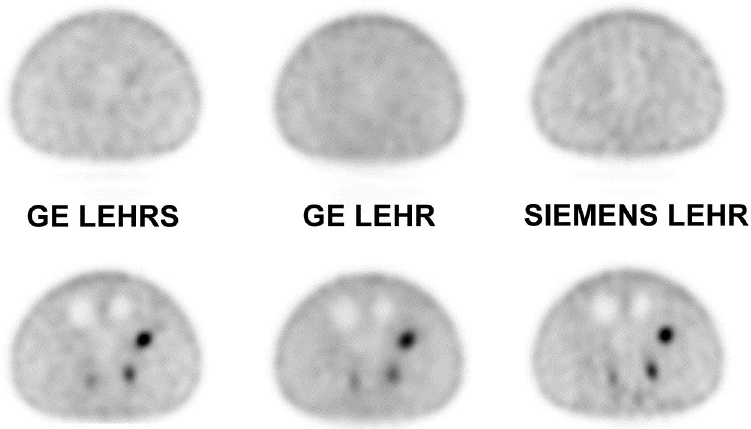
Fig 3. Phantom data. The best signal intensity is observed on Siemens LEHR acquisitions but noise is better controlled with GE Swiftscan solution.